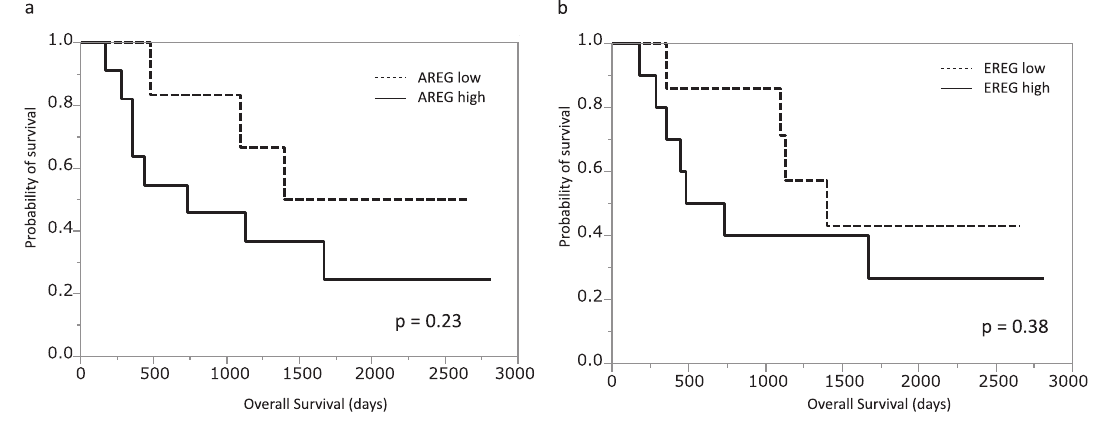
Figure 5. OS in patients with stage IV colorectal cancer according to AREG and EREG expression. a: OS of patients according to AREG expression. b: OS of patients according to EREG